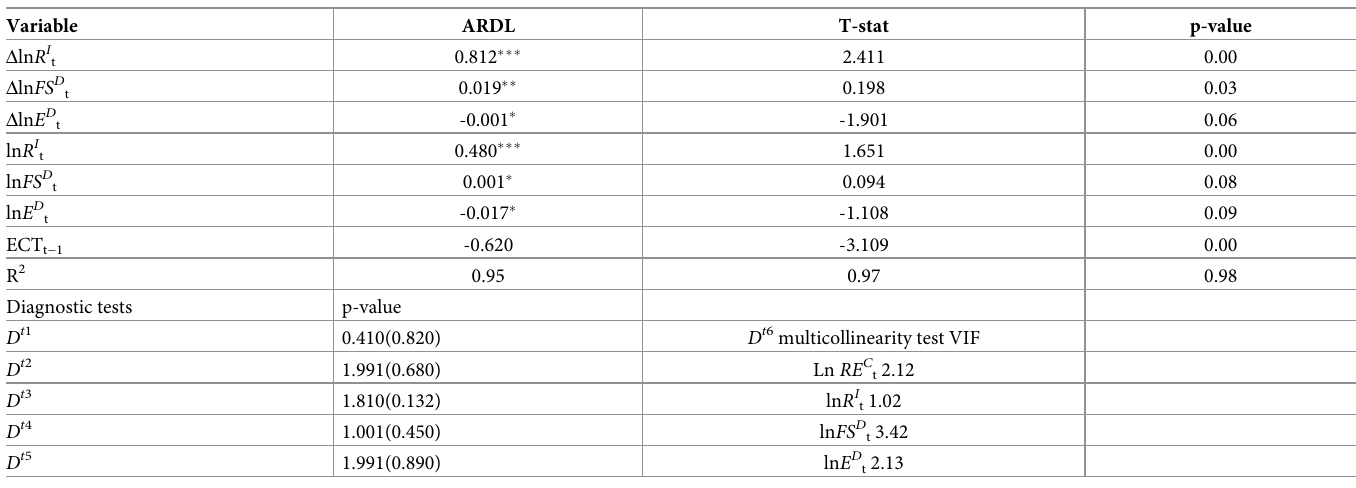
Table 6. Short and Long-run coefficients, ARDL.